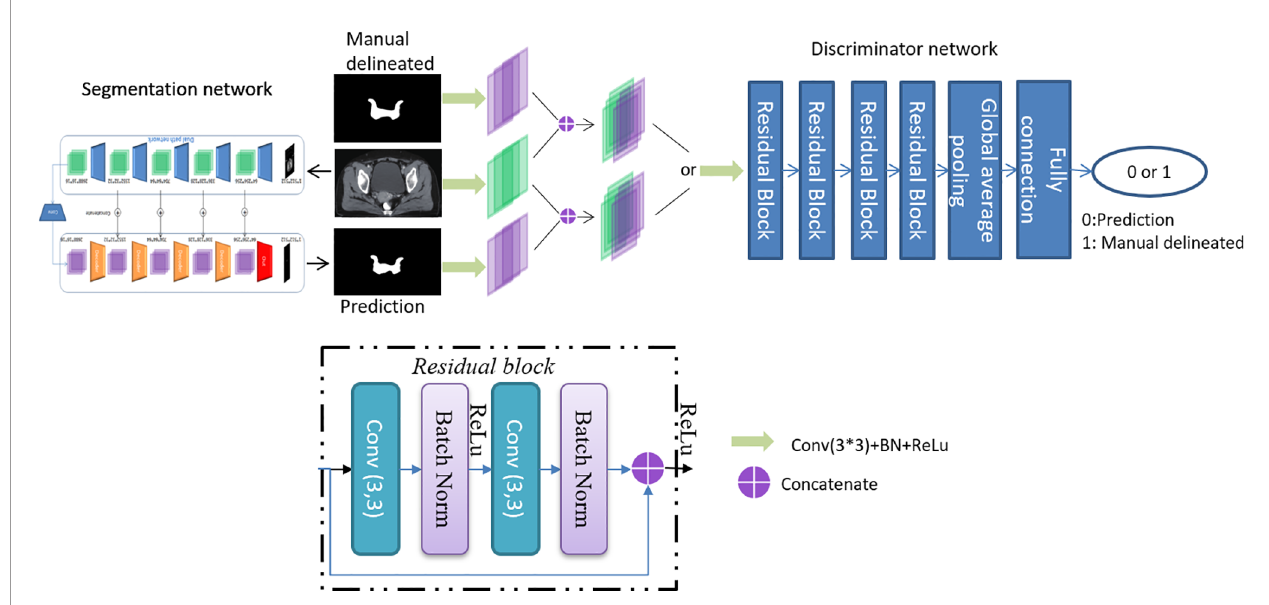
FIGURE 1 | The overall architecture of the proposed